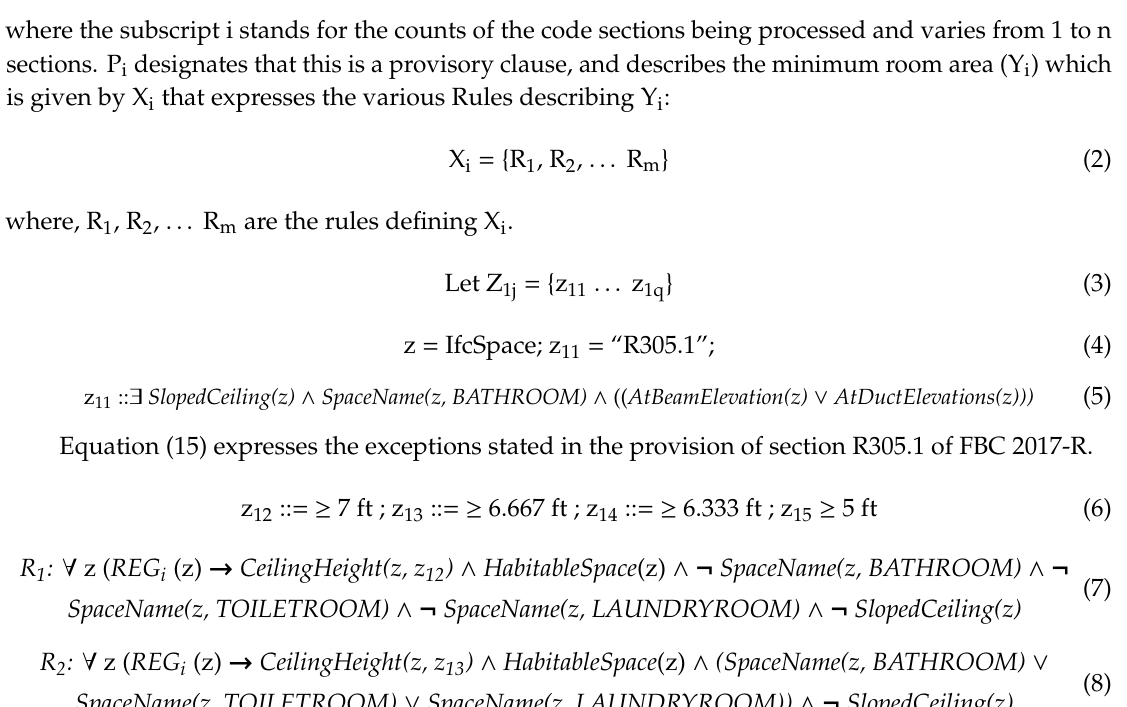
Figure 4. Section R305 of Florida Building Code 2017– Residential.